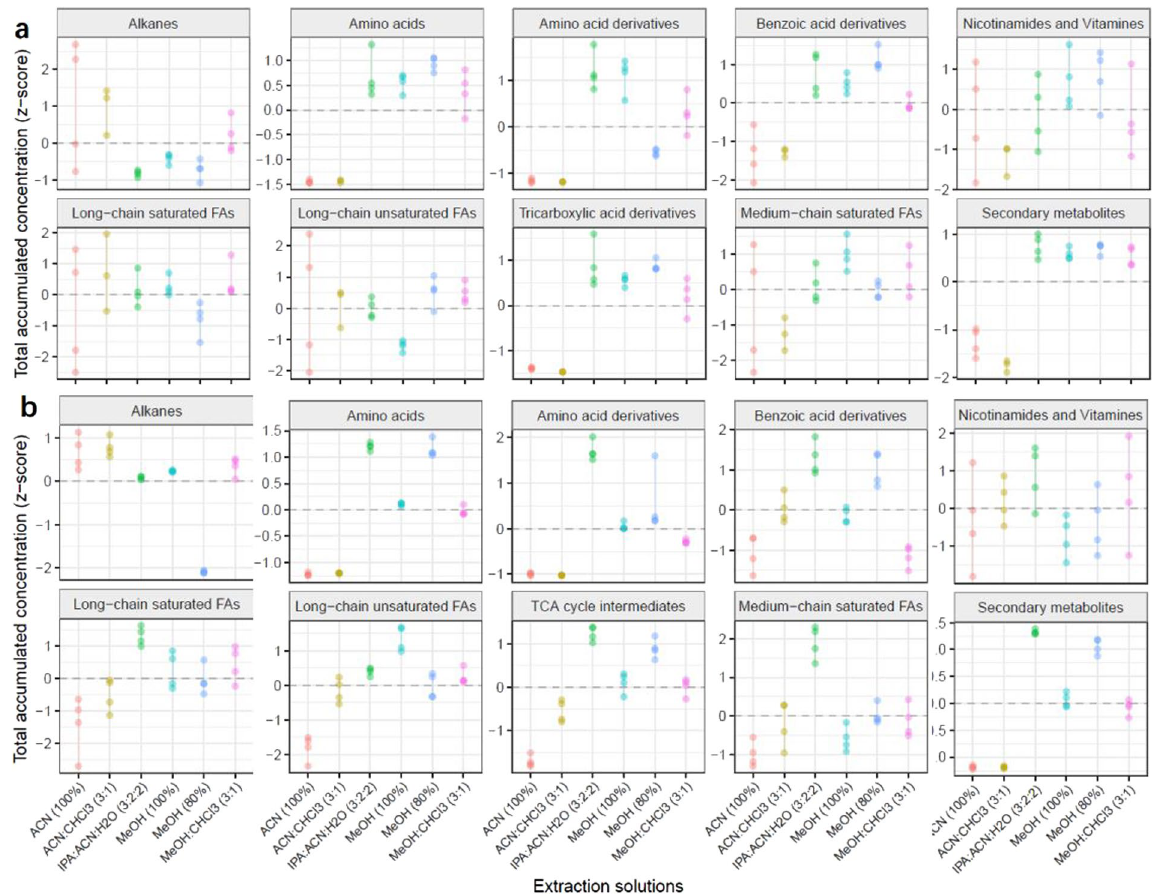
Figure 7. The dot-line graphs show the total concentrations of metabolites in each metabolic biochemical class across six different extraction solvents for adult ( a ) and baby ( b ) giant panda feces. Each dot represents a sample concentration. Red dots: ACN (100%); green dots: MeOH (100%); blue dots: MeOH (80%); cyan dots: ACN:CHCl 3 (3:1); purple dots: IPA:ACN:H 2 O (3:2:2); yellow dots: MeOH:CHCl 3 (3:1). The vertical lines are the standard deviation of each extraction method. The metabolite concentrations were standardized to